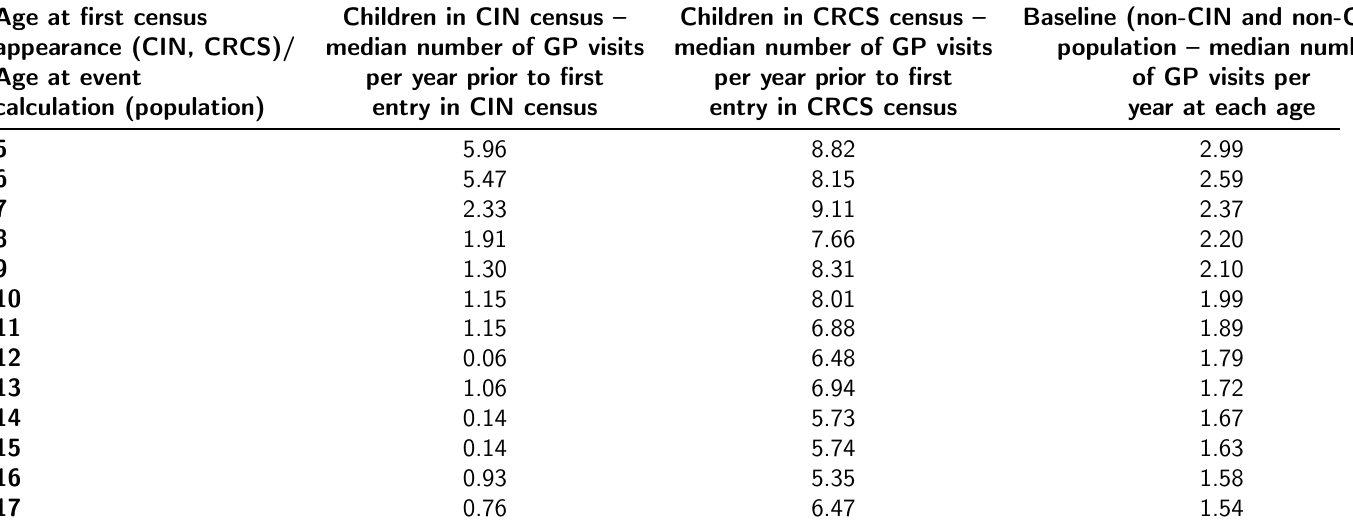
Table 5: Absolute values of the median number of GP consultations per year of age Age at first census Children in CIN census – Children in CRCS census – Baseline (non-CIN and non-CRCS) median number of GP visits median number of GP visits population – median number per year prior to first of GP visits